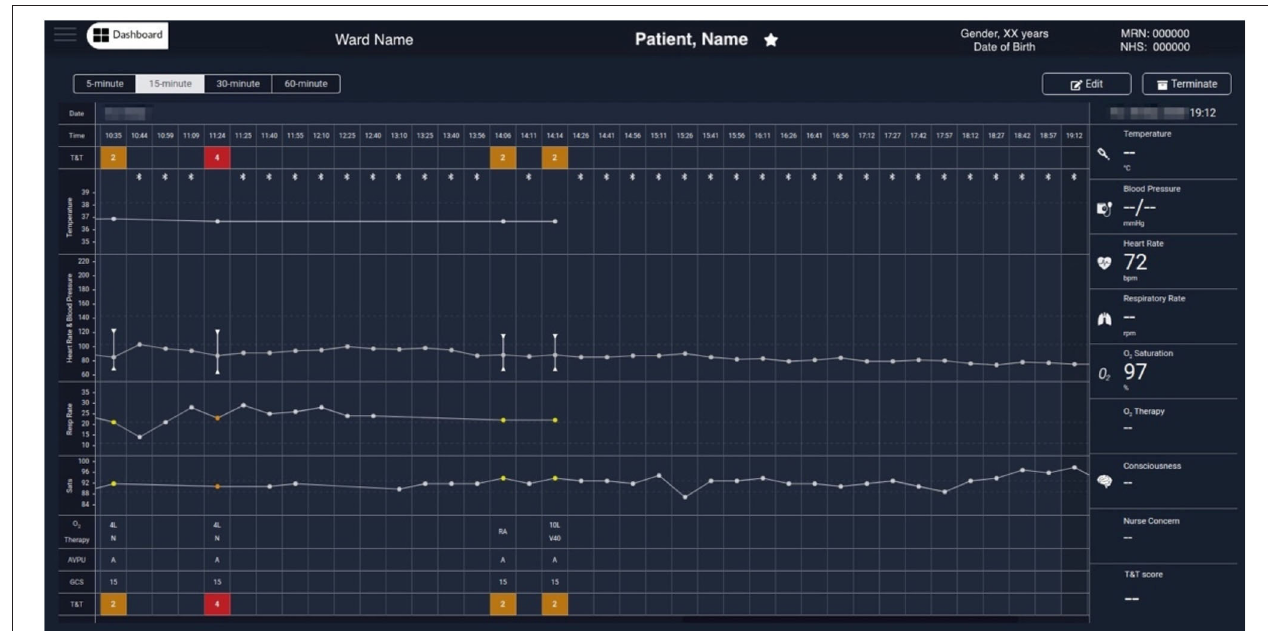
FIGURE 6 | Exemplar augmented e-obs chart from the Clinician Dashboard, showing wearable and e-obs vital-sign data from a COVID-19 patient in the isolation room. In this example, the wearable data from 10:44 to 19:12 is summarised in 15-min windows (i.e., the “15-min” view was activated, and only the most recent available 5-min median estimates within each window are displayed), and shown alongside the intermittent e-obs data. Only the e-obs data had scores associated with it, presented in the T&T row at the top and bottom of the chart. In this hospital setting an Early Warning Score (EWS) greater or equal to 3 was coloured red, denoting high risk. In the period displayed in the chart, the VitalPatch ® was already fitted. The increase in the VitalPatch ® RR, might have triggered the nurse review of the patient 1h after the previous review (usually done 4-hourly when the previous total EWS is 2), as an additional e-obs set was entered by the nurse at this time, with high RR (24 rpm), low SpO 2 (90%) values and a total EWS of 4 (1h after the previous e-obs set, at 10:35 AM). We note that at this point the patient was receiving oxygen therapy via a nasal cannula (N) at 4 litres per minute. It is possible to observe that, in the subsequent 3h, the VitalPatch ® was removed and the Nonin pulse oximeter fitted to the patient to monitor the SpO 2 while the oxygen therapy was escalated, by applying a Venturi Mask 40 (V40) at 10 litres per minute, at 14:14. A recovery trend can be observed, with HR and SpO 2 estimates from the Nonin pulse oximeter stabilising in the evening at 72 bpm and 97%, respectively (displayed at the end of the chart). Note that a nurse e-obs set is absent during this period in the chart (i.e., between 14:14 and 21:23, the time at which the patient was removed from the vHDU system; the chart only shows up to 19:12). MRN, Medical Record Number; NHS, National Health Service; T&T, Track & Trigger; Sats, peripheral